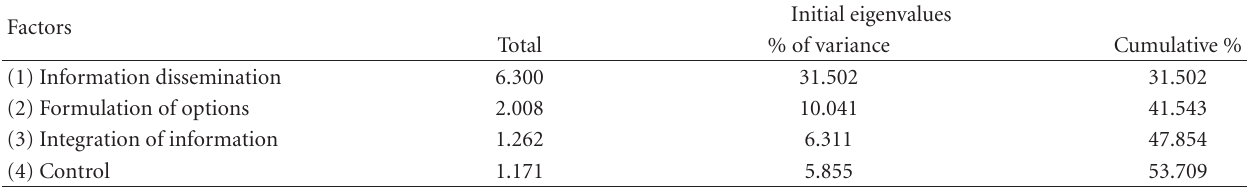
Table 4: Initial eigenvalues, percent of variance and cumulative percent, and the total variance for 20 items and 4 factors.